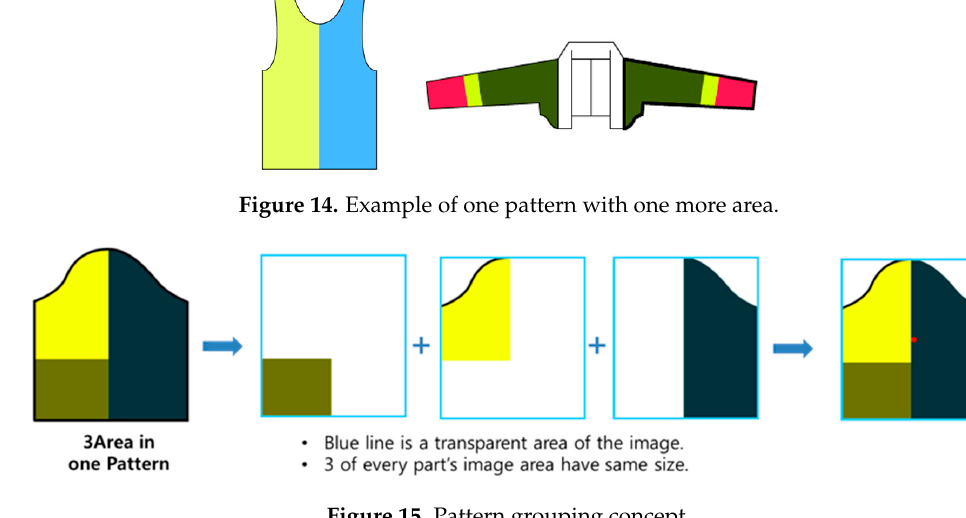
Figure 15. Pattern grouping concept.